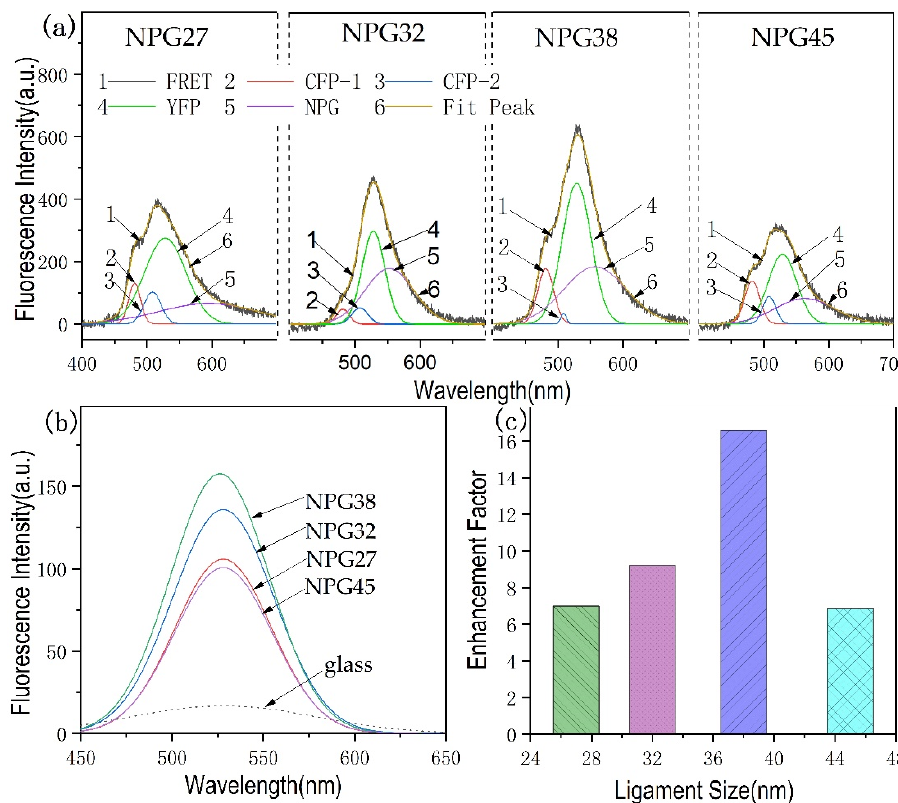
Figure 3. Fluorescence spectra and Enhancement Factor. ( a ) Fluorescence spectra of donor (CFP)- acceptor (YFP) on NPG with different ligament sizes when the spacing distance is around 10.5 nm. ( b ) Fluorescence spectra of YFP only on NPG with different ligament sizes and glass slide. ( c ) Enhancement factor of YFP with CFP and NPG substrate.